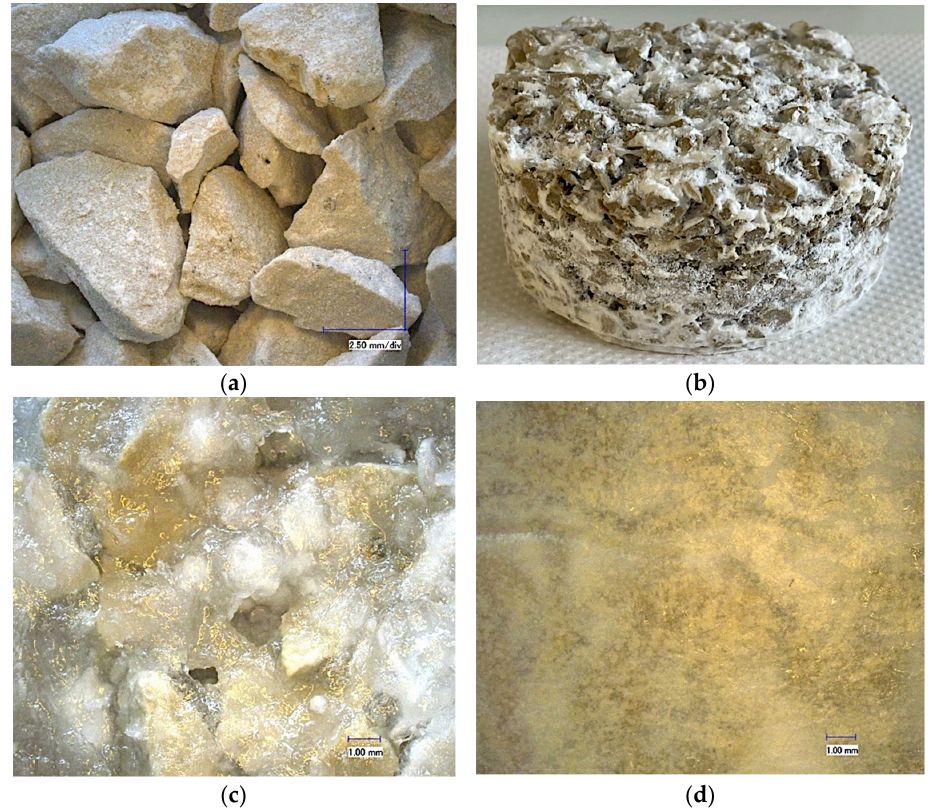
Figure 8. Bulk model with a fraction of ground carbonate rock more than 2.5 mm after pumping the hardening composition. ( a ) Snapshot of the bulk model at ×100 magnification on a Keyence VHX-600 microscope; ( b ) general view of the bulk model after the experiment; ( c ) snapshot of the bulk model after the experiment at ×100 magnification (top view); and ( d ) photograph of the bulk model after the experiment at ×100 magnification on a microscope (bottom view).